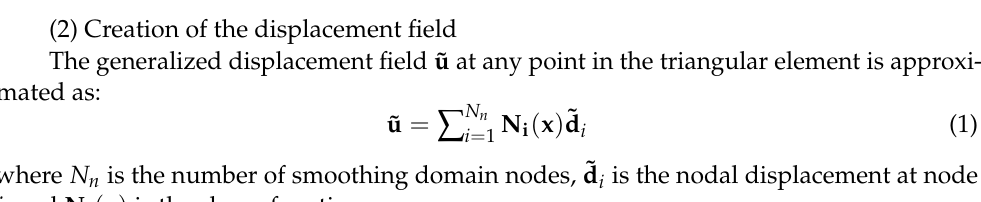
Figure 2. Polygon element mesh and the edge-based smoothing domain in